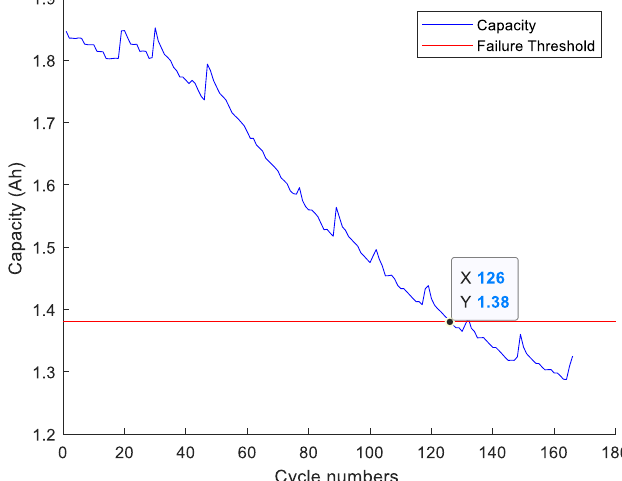
Figure 2. Capacity changing curve during the whole Li-ion battery life.